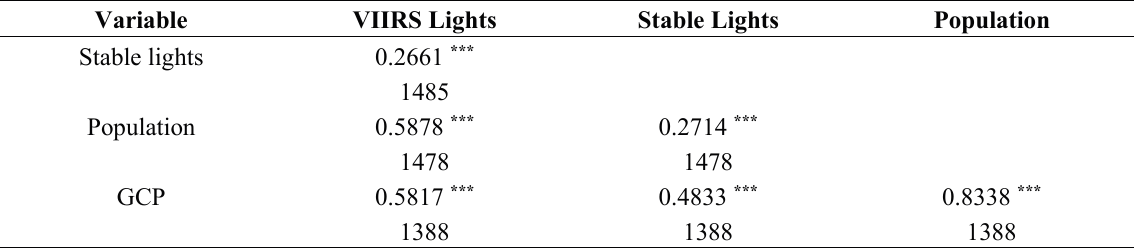
Table 5. Pairwise correlations for cells with population less than 100,000 ( *** p < 0.001).